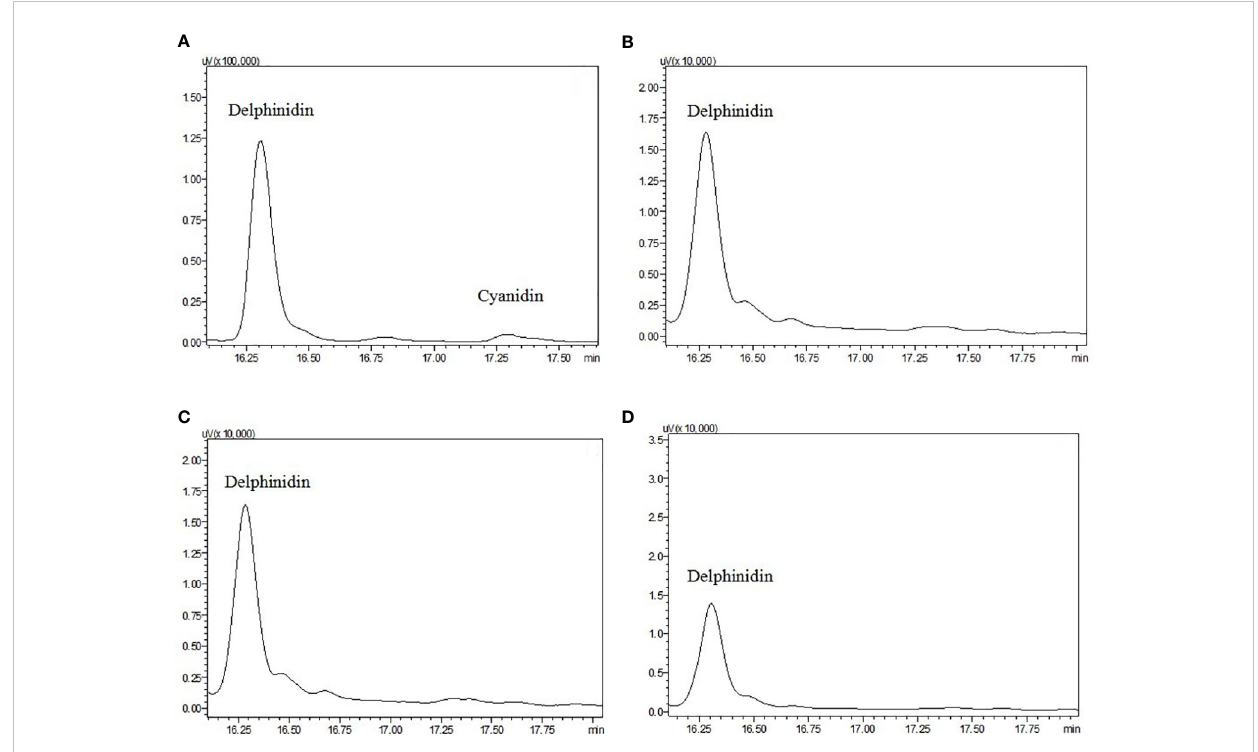
FIGURE 3 High-performance liquid chromatograms of extracts from petals and sepals of anthocyanidin pigments from (A) E. acuminatum , (B) E. epstenii , (C) E. zhushanense and (D) E. leptorrhizum . Peaks labeled represent the standards of each of the